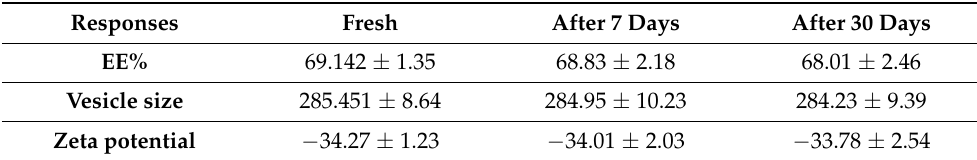
Table 6. The effect of storage at 4 °C for one month on EE%, Vesicle size and Zeta potential of the optimized formula.